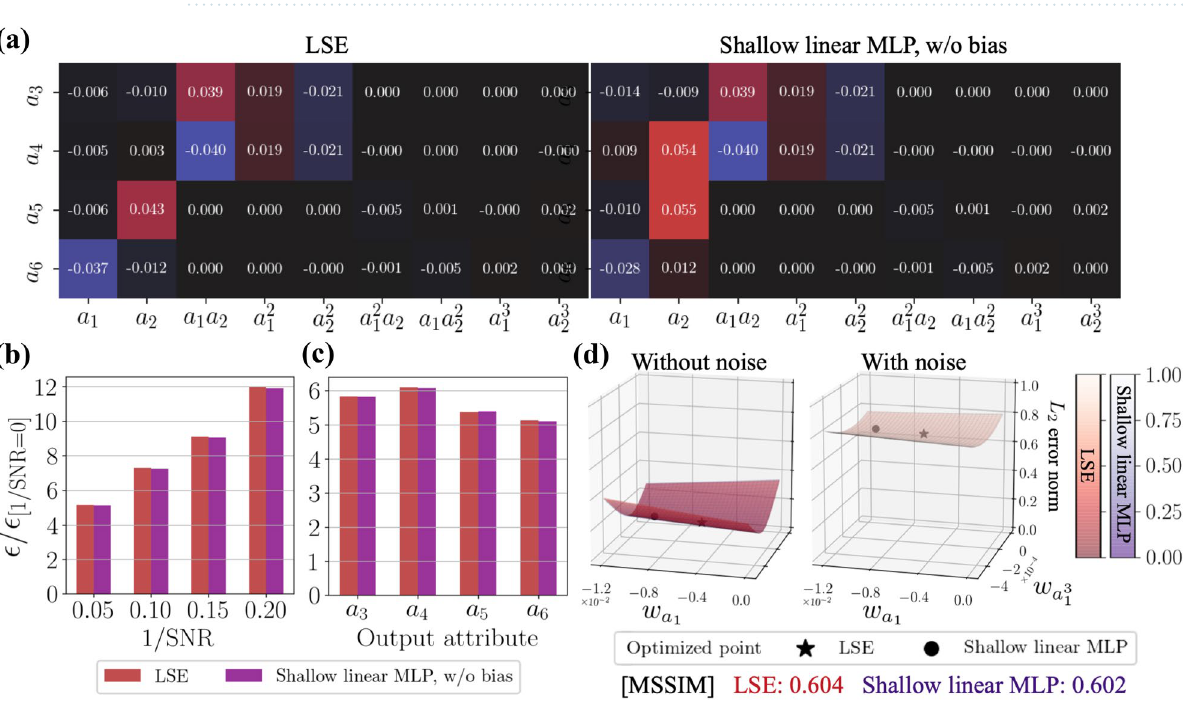
Figure 6. Comparison of the LSE and the linear MLP trained with the noisy training data. ( a ) Weight values of the LSE and the shallow linear MLP. ( b ) Increasing ratio ε/ε [ 1 / SNR = 0 ] of the L 2 error norm ε from the original error ε [ 1 / SNR = 0 ] without the noisy input. ( c ) Dependence of the increasing ratio ε/ε [ 1 / SNR = 0 ] of the L 2 error norm at 1 / SNR = 0.05 on the output POD coefficients. ( d ) Visualization of the error surface around the optimized